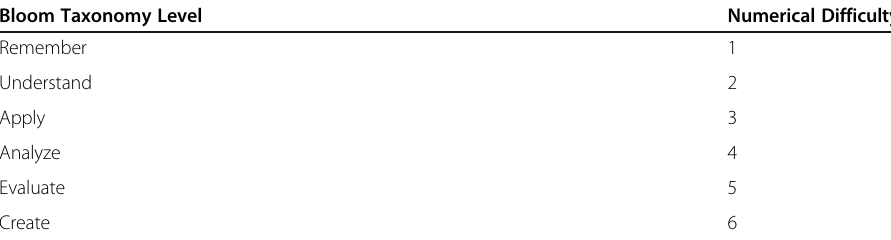
Table 3 Bloom taxonomy and corresponding numerical difficulty value Bloom Taxonomy